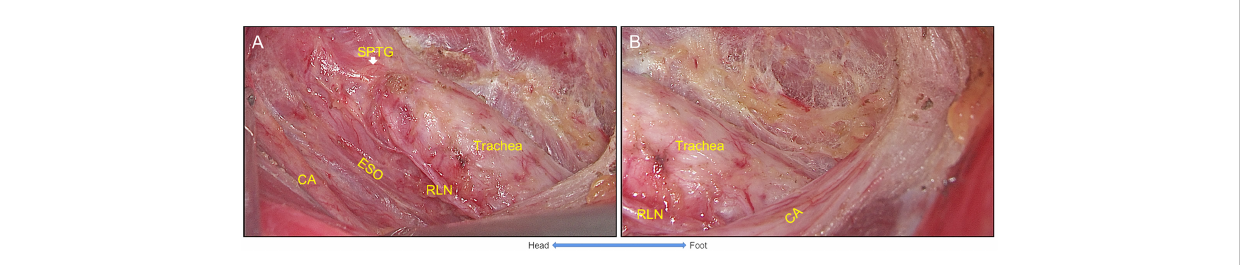
FIGURE 6 The view of unilateral ET+CCND via GUA approach with the fi ve-settlement method. (A) The endoscopic lobectomy and central neck compartment dissection was completed with the superior parathyroid gland preserved. (B) The lower boundary of the central compartment was exposed (carotid artery), and the thymus and inferior parathyroid gland were preserved (IPTG within the thymus and retracted underneath the carotid artery). ET+CCND, endoscopic thyroid lobectomy, and ipsilateral central compartment neck dissection; GUA, gasless unilateral axillary; SPTG, superior parathyroid gland.